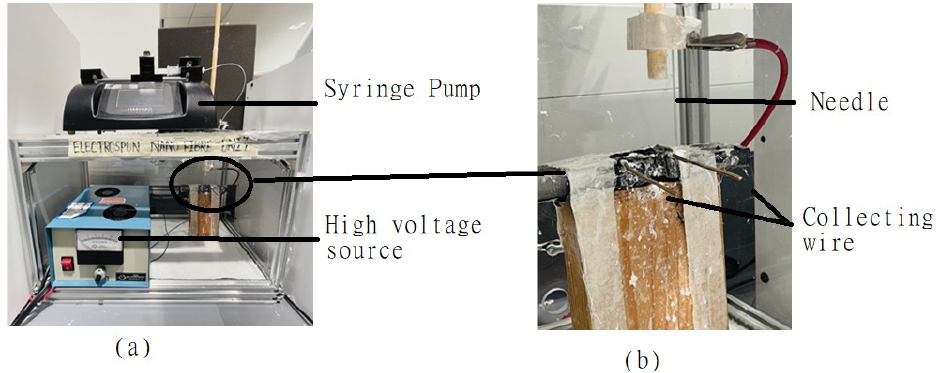
Figure 1. Electrospun nanofiber unit to produce PCL NFM. ( a ) Entire setup and ( b ) magnified inset from circled area in ( a ) showing nanofiber mesh collection setup consisting of two parallel rods.